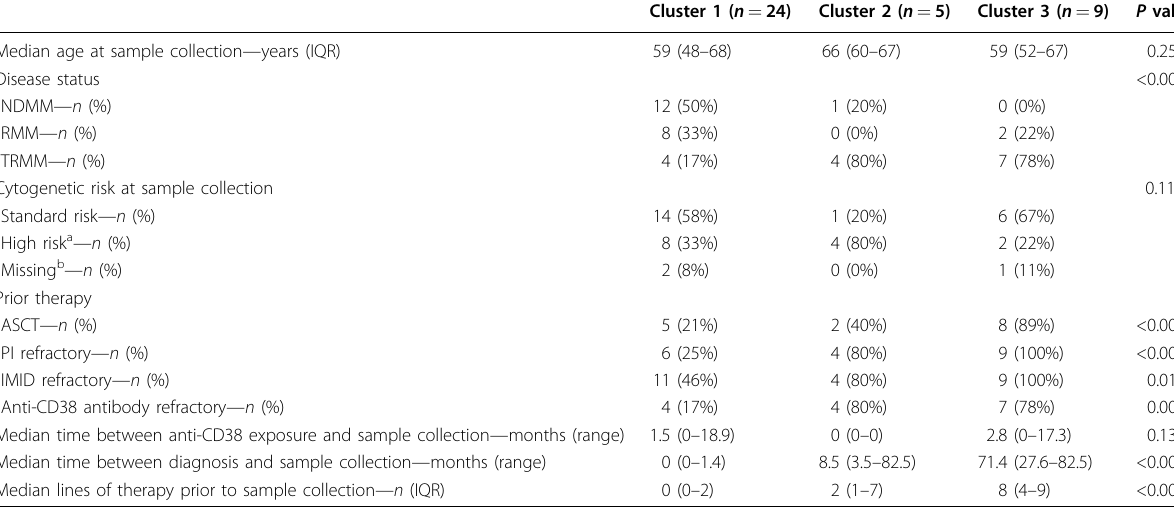
Table 1 Characteristics of multiple myeloma grouped by the distinct immune cell clusters.